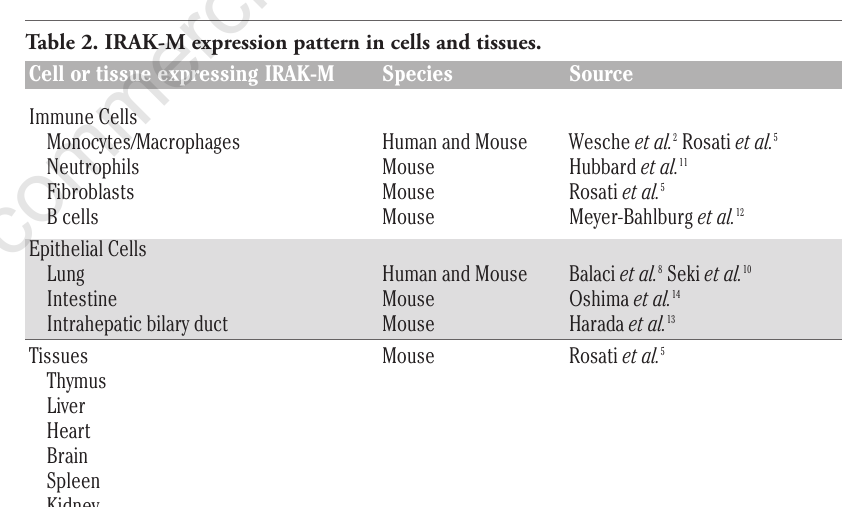
Table 2. IRAK-M expression pattern in cells and